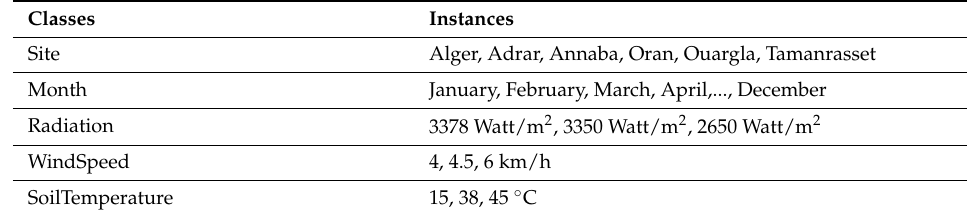
Table 4. Examples of instances.